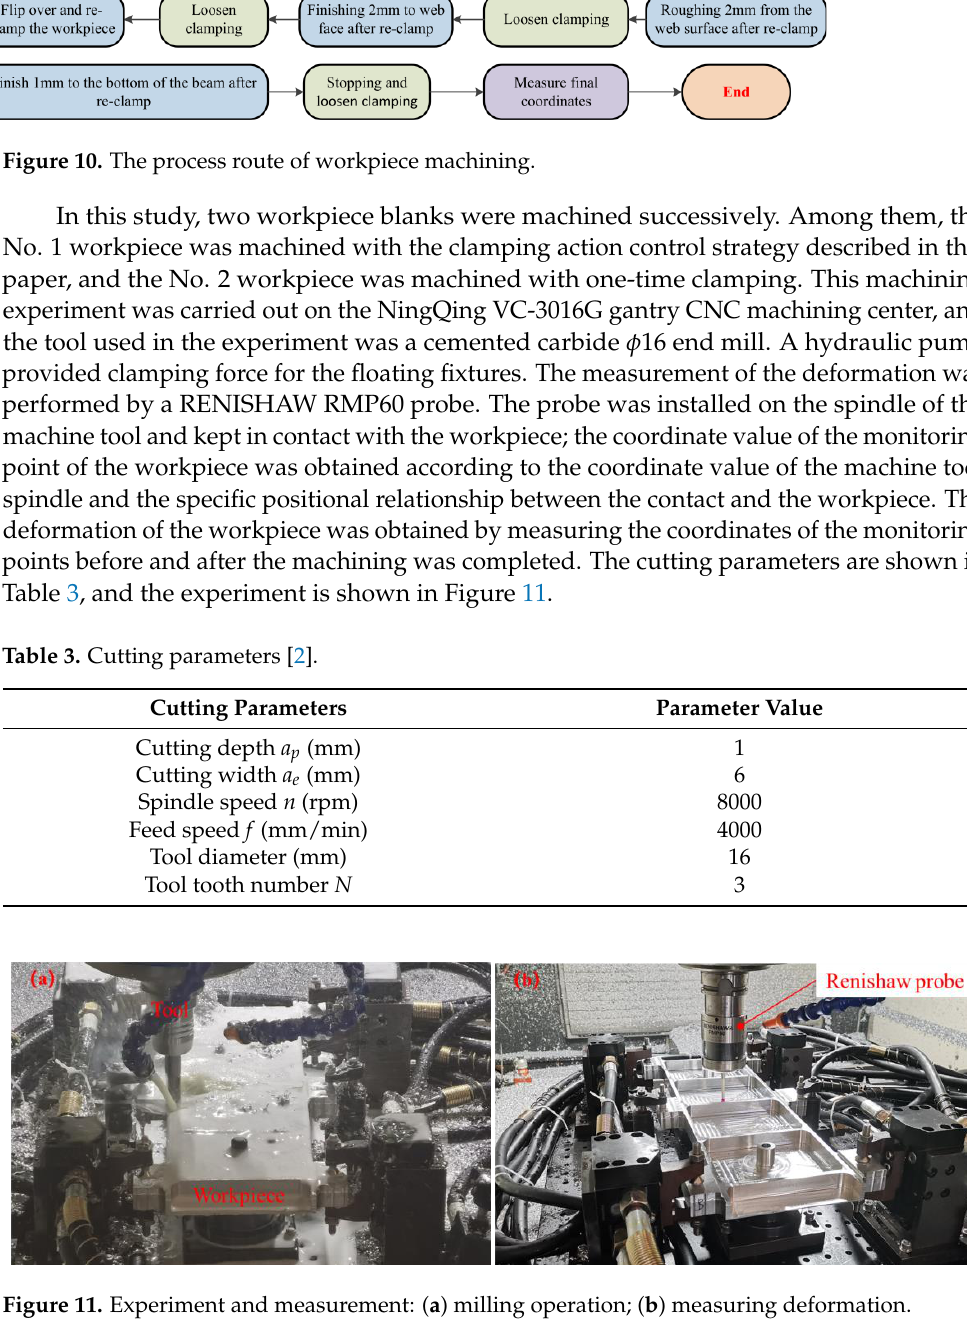
Figure 9. Floating clamping system.